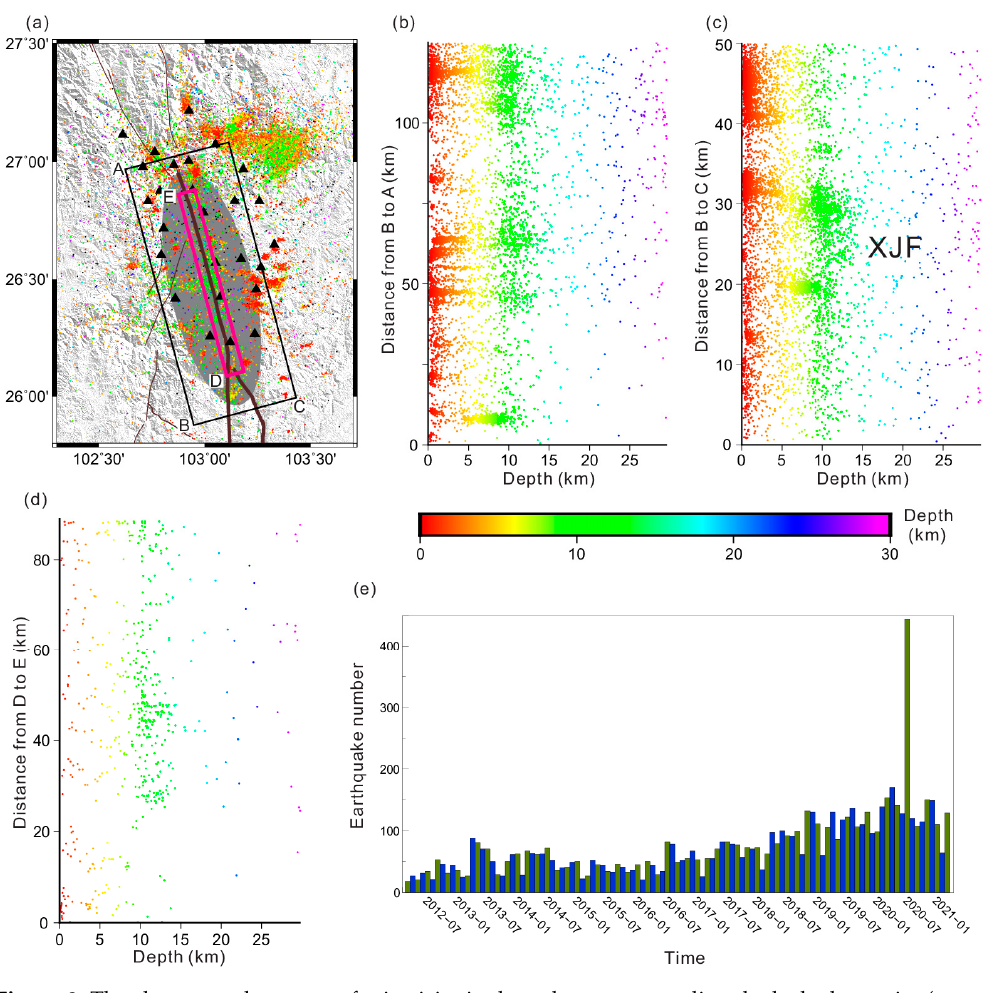
Figure 8. The clusters and swarms of seismicity in the volume surrounding the locked asperity (gray ellipse). ( a ) The M < 2 earthquakes (small circles) recorded by our near-fault seismic stations (black triangles) in the period of February 2012 to March 2021. The 50 km wide black frame surrounds the entire locked asperity, whereas the 6 km wide purple frame merely surrounds the central part. ( b ) The seismicity in the larger frame projected on the cross-section parallel to the fault plane (see sides